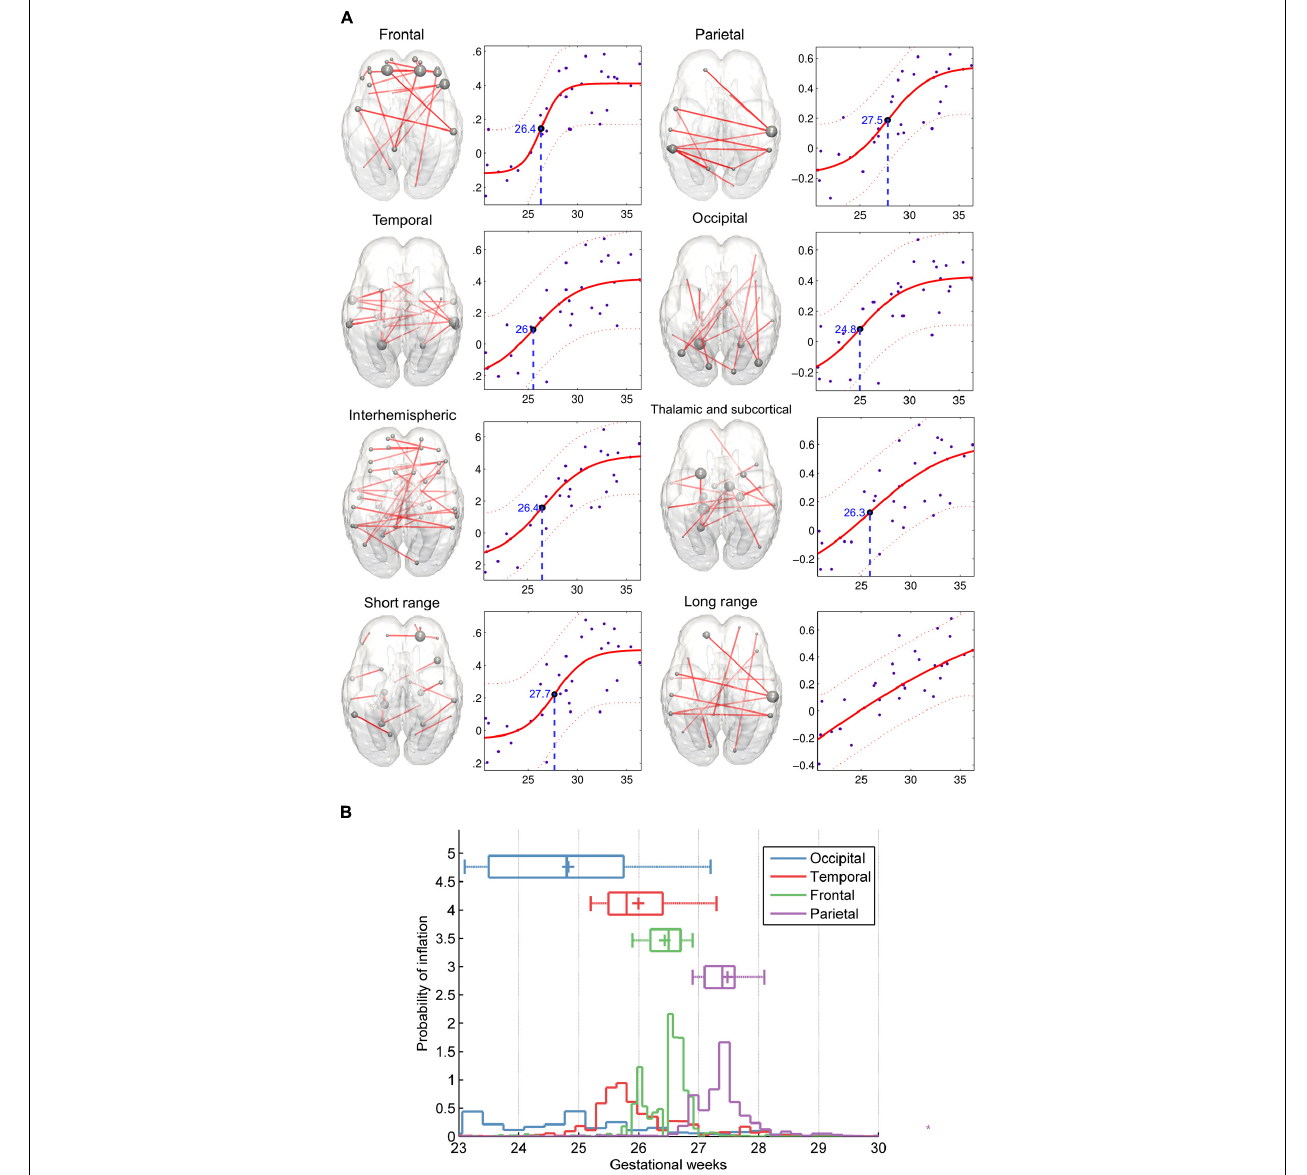
of functional brain connectivity expansion during the late second and third trimester, variability of the observed inflation times during the bootstrapping procedure. According to the hypothesis that functional connectivities exhibit non-linear growth characteristics rather than a linear trend during the mid-fetal period, it is possible to determine the gestational age of inflation by sampling. 50% of the measurement points were sampled randomly during this procedure, and the relative probability estimates of the inflation points of the fitted functions are depicted against the gestational age. The distribution of sampled connections indicates a sequence of occipital, temporal, frontal, and parietal development of intrinsic functional connectivity